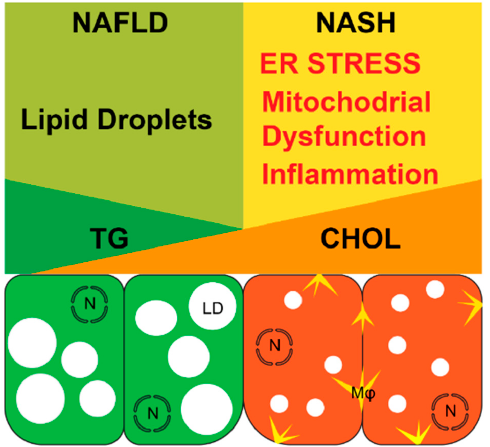
Figure 1. The key features that distinguish NAFLD from NASH. N: Nucleus, LD: Lipid Droplet, M φ : Macrophages.